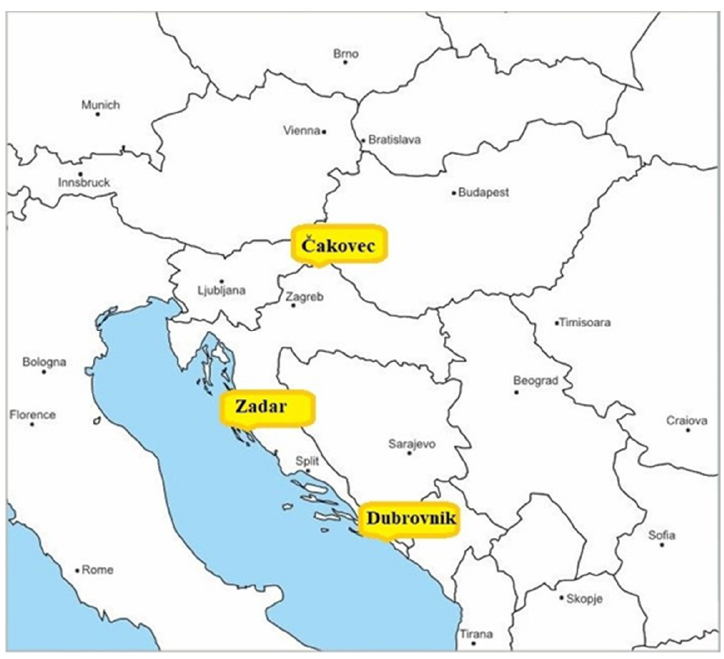
Figure 1. The wide geographic area of selected GNSS measuring stations.